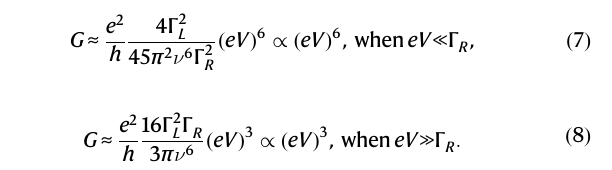
Fig. 3 | Conductance calculated with Eq. (6) for our system. The blue and red dashed lines highlight power laws in different limits. The conductance G ≪ e 2 / h is required in both limits.